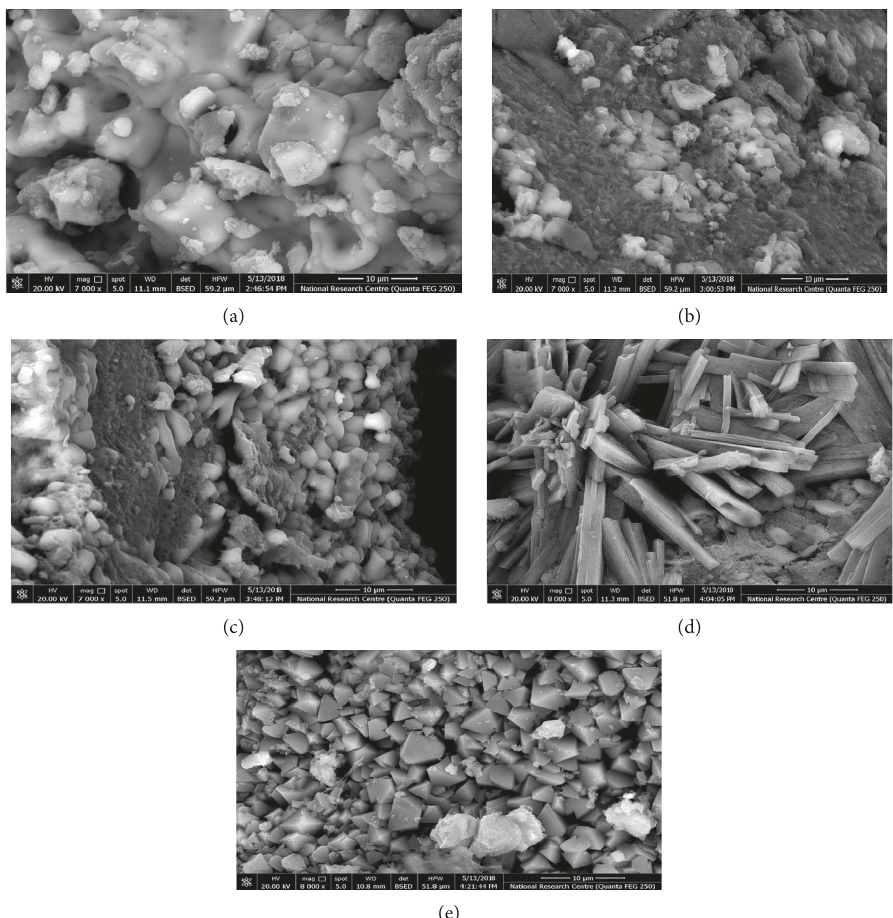
Figure 3: (a) SEM photo of prepared sample A. (b) SEM photo of prepared sample B. (c) SEM photo of prepared sample C. (d) SEM photo